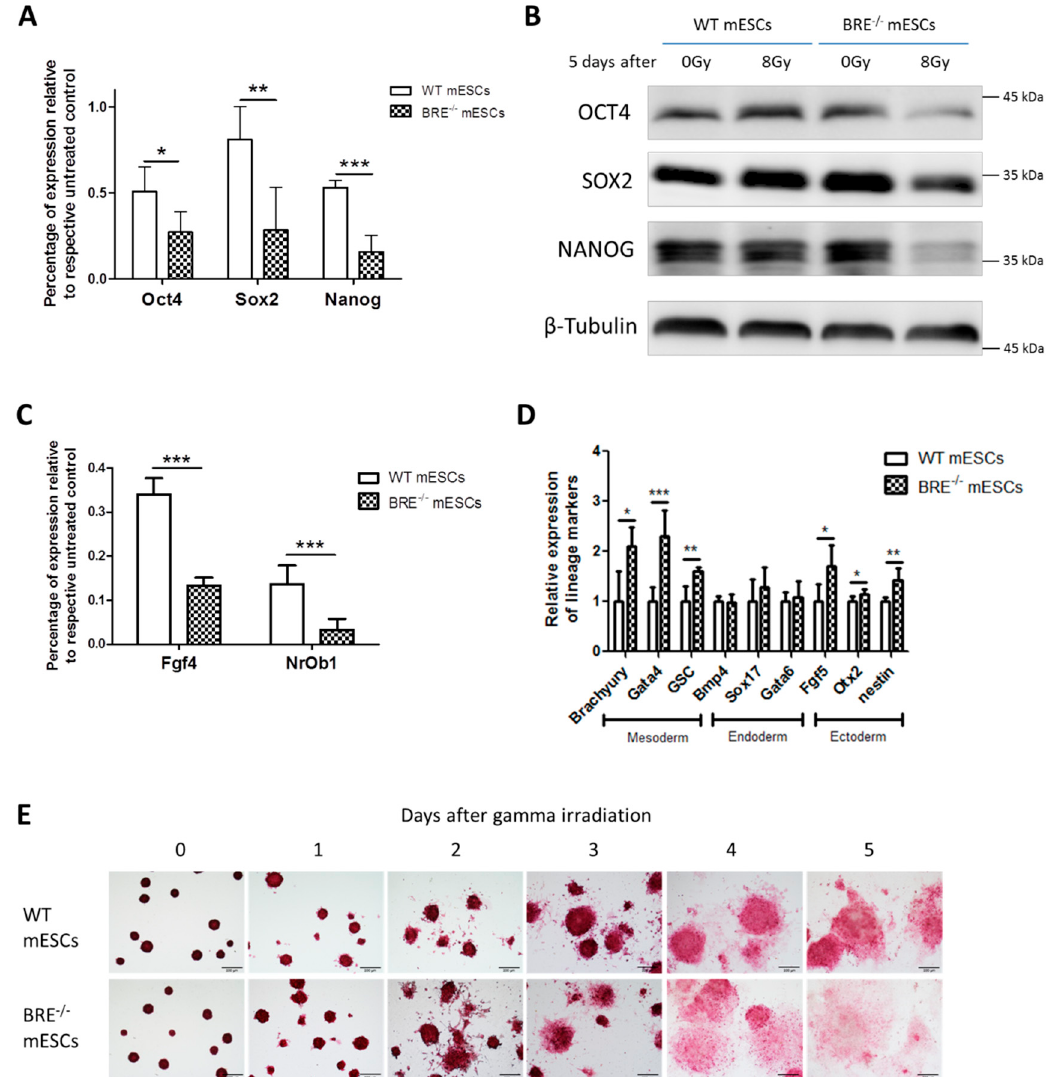
Figure 6. Expressions of pluripotency-associated genes were su ffi ciently downregulated in Babam2 − / − mESCs after 8 Gy of gamma irradiation treatment. ( A ) Relative protein expression of pluripotency-associated genes in 5 days post-irradiation (8 Gy) treated and untreated Babam2 − / − and WT mESCs. Data represent the mean ± SD of three independent experiments. *, p < 0.05, **, p < 0.005, ***, p < 0.001, two-sided unpaired t -test. ( B ) Western blot analysis of pluripotent markers, OCT4, SOX2, and NANOG, in Babam2 − / − and WT mESCs, 5 days after 8 Gy treatments. ( C ) Relative mRNA expression of naïve stem cell markers in 5 days post-irradiation (8 Gy) treated and untreated Babam2 − / − and WT mESCs. Data represent the mean ± SD of three independent experiments. ***, p < 0.001, two-sided unpaired t -test. ( D ) Relative mRNA expression level of di ff erentiation gene markers, normalized against Gapdh in Babam2 − / − and WT mESCs 5 days post-irradiation. Data represent the mean ± SD of three independent experiments. *, p < 0.05, **, p < 0.005, ***, p < 0.001, two-sided unpaired t -test. ( E ) Representative images of alkaline phosphatase staining of Babam2 − / − and WT mESCs at different day intervals following 8 Gy of gamma irradiation treatment. Scale bar = 200 μ m.